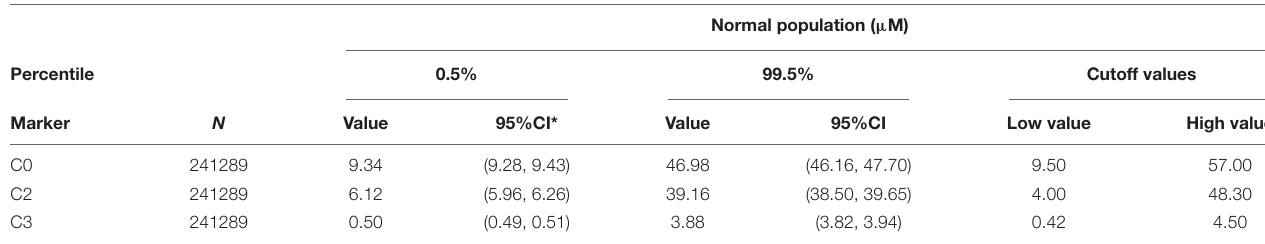
TABLE 1 | Cutoff values and 0.5%/99.5% percentiles used for free carnitine (C0), acetylcarnitine (C2), and propionylcarnitine (C3).